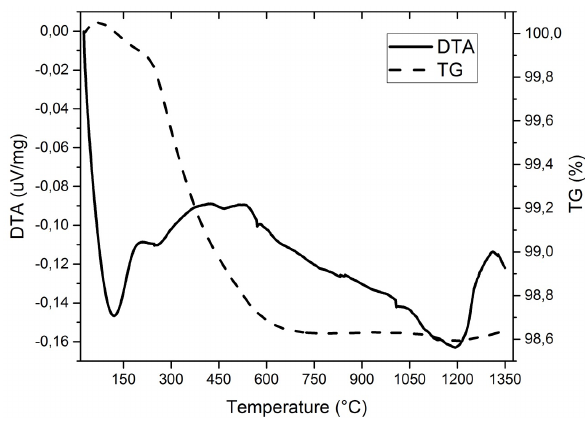
Figure 6. Simultaneous DTA–TGA analysis of Sille stone Figure 6: Simultaneous DTA–TGA analysis of Sille